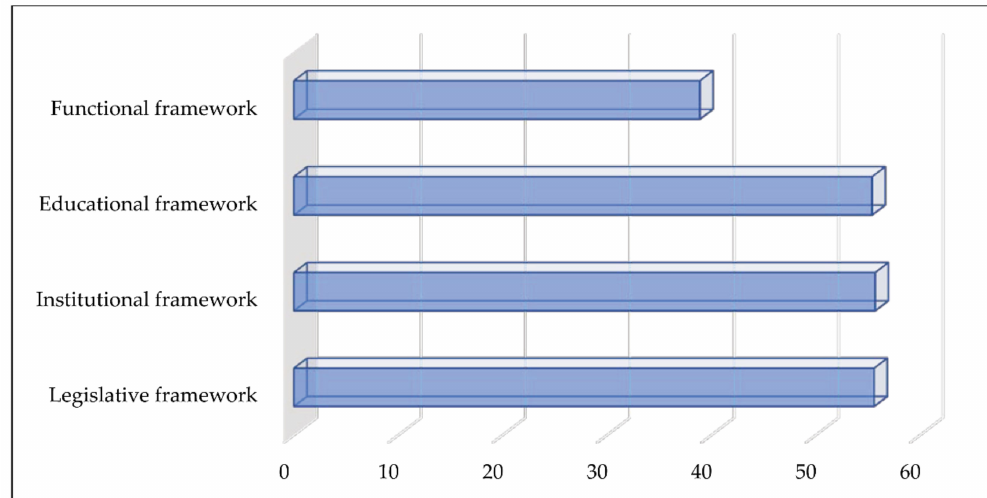
Figure 6. Forms of assistance needed to improve local regulatory acts or compose them